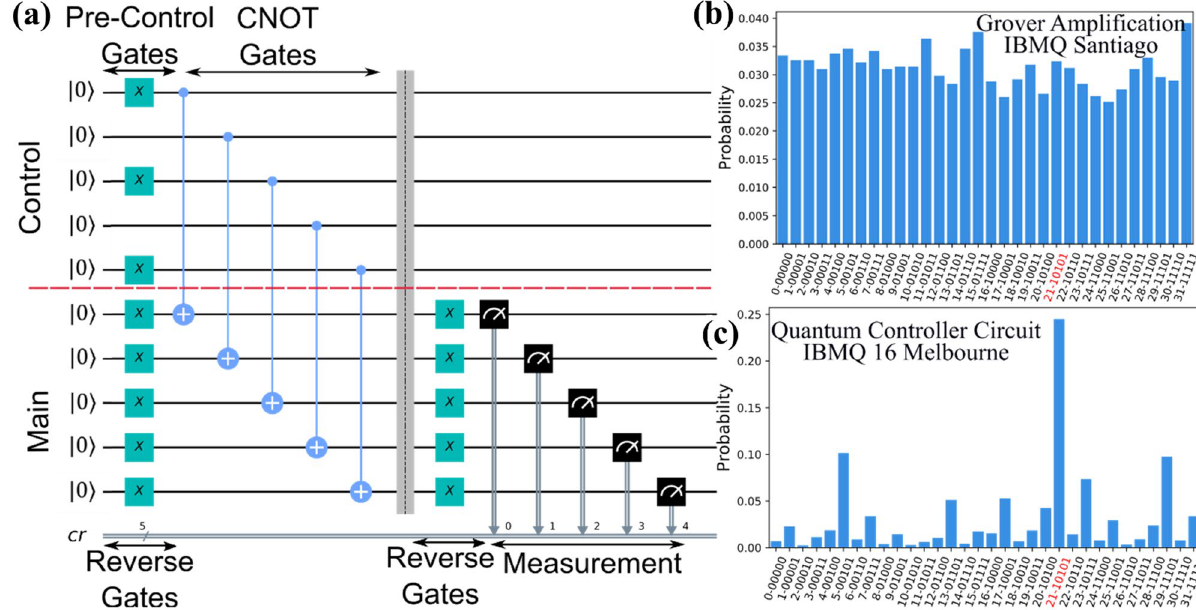
Figure 5. Quantum controller circuit for a 5 qubit (32 bit) system. ( a ) Quantum controller circuit for the selection of the state | 10101 � . The probability distribution corresponding to ( b ) failed Grover’s amplification